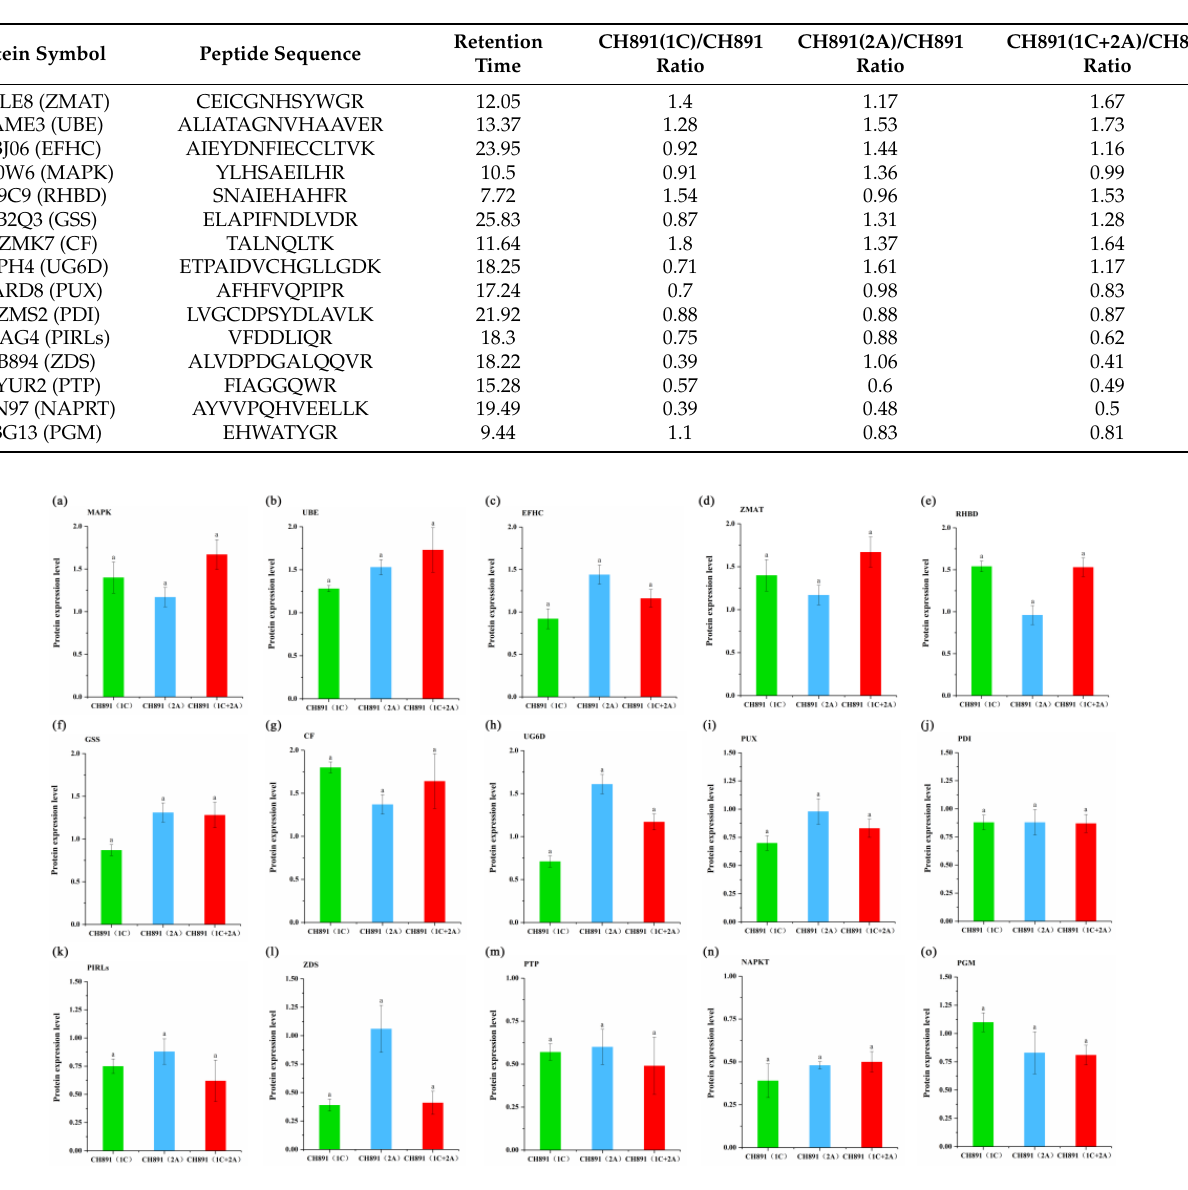
Figure 12. Parallel reaction monitoring (PRM) of proteins involved in the COG enrichment pathways by three transgenic events. Samples were obtained from leaves at the heading stage in CH891(1C), CH891(2A), and CH891(1C+2A). ( a – o ) represents PRM results of key enzymes MAPK, UBE, EFHC, SHMT, PPI, GSS, CF, UG6D, PUX, PDI, PIRLs, ZDS, PTP, NAPKT, and PGM, respectively. Relative protein rates of each sample were compared to those in CH891. The data are means of three biological replicates; different letters indicate significant differences within NIL groups ( p < 0.05), and bars between columns indicate significant differences among proteins among NIL groups. Data followed by different lower-case letters denote significant differences between relative protein rates of each sample at the 5% level according to LSD